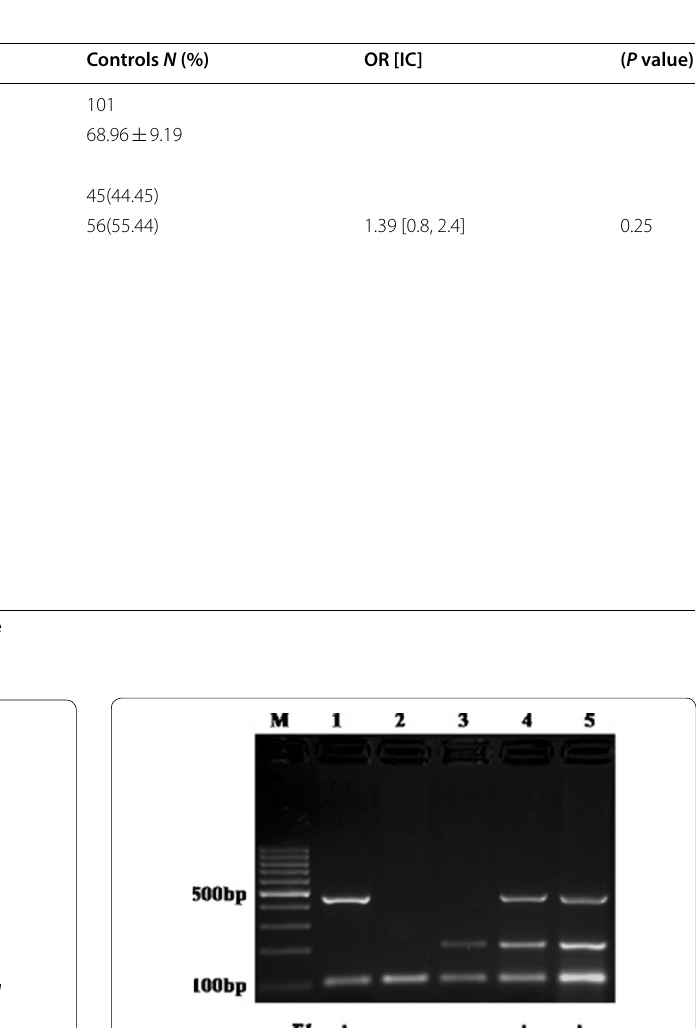
Table 1 Characteristics of the study population